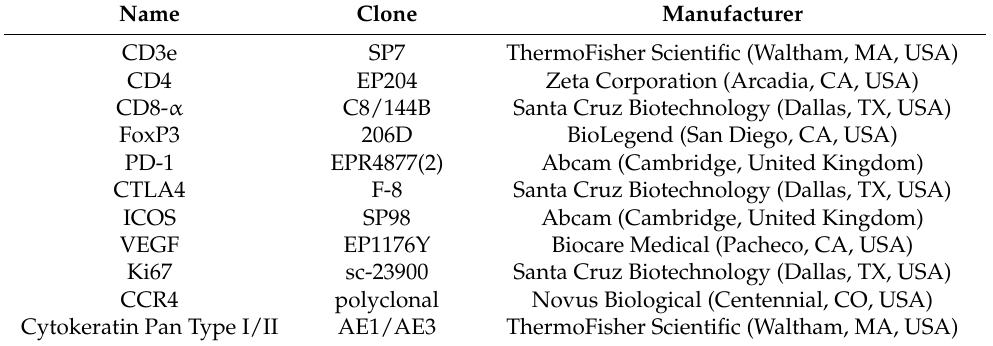
Table 1. List of antibodies.